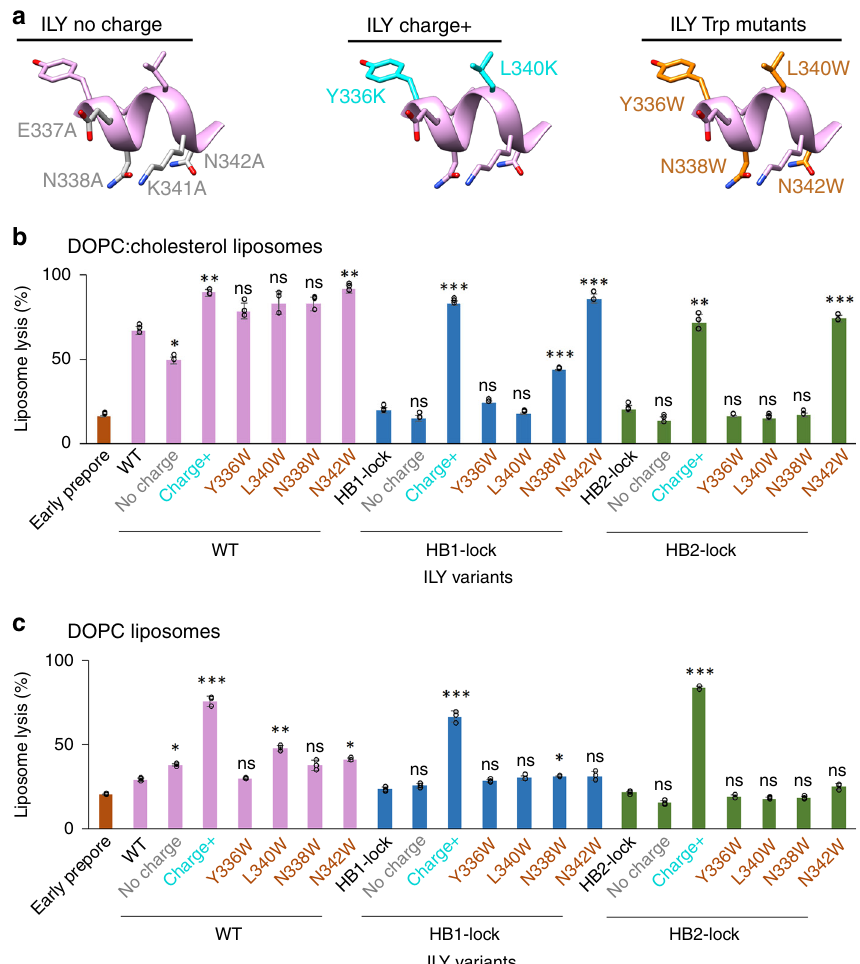
Fig. 3 Targeted mutations in the horizontal helix (h-helix) tune lytic activity of ILY. a H-helix mutations are mapped onto the ILY structure. Left panel (ILY no charge) highlights residues (gray) exchanged for alanine (E337A, N338A, K341A, N342A) on the membrane proximal face of the h-helix. Middle panel (ILY charge + ) indicates residues (cyan) mutated to lysine (Y336K, L340K) on the top face of the helix. Right panel (ILY Trp mutants) shows the location of residues (orange) mutated to tryptophan (Y336W, N338W, L340W, or N342W). Sidechains have been added in COOT 44 for visualization purposes. b , c Activity of ILY h-helix mutants in wild type (WT), HB1-lock or HB2-lock backgrounds were tested after 45 min using a calcein-release liposome lysis assay. Lysis of CD59-decorated liposomes comprised of DOPC:cholesterol lipids is shown in ( b ). Lysis of CD59-decorated DOPC liposomes is in ( c ). Statistical signi fi cance displayed above each bar is for comparison with the base ILY disul fi de-locked variant (WT, HB1-lock, or HB2-lock, respectively). Individual data points from three independent experimental assays are shown as circles. Error bars represent standard deviation with the center of the bar indicating the mean value. P -value signi fi cance determined by one-way ANOVA with a Bonferroni post-test: ns, not signi fi cant; * p < 0.05; ** p < 0.01; *** p <